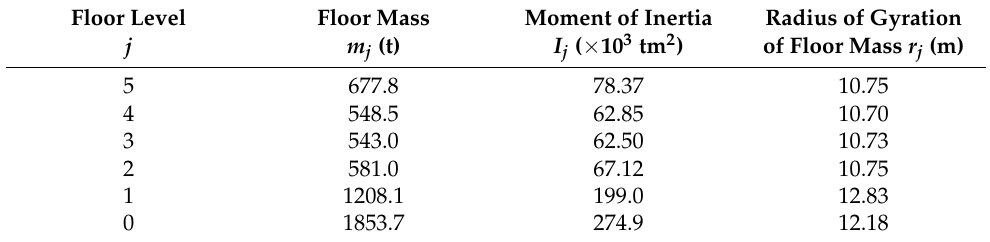
Table 1. Floor mass, moment of inertia, and radius of gyration of the floor mass of each floor level.